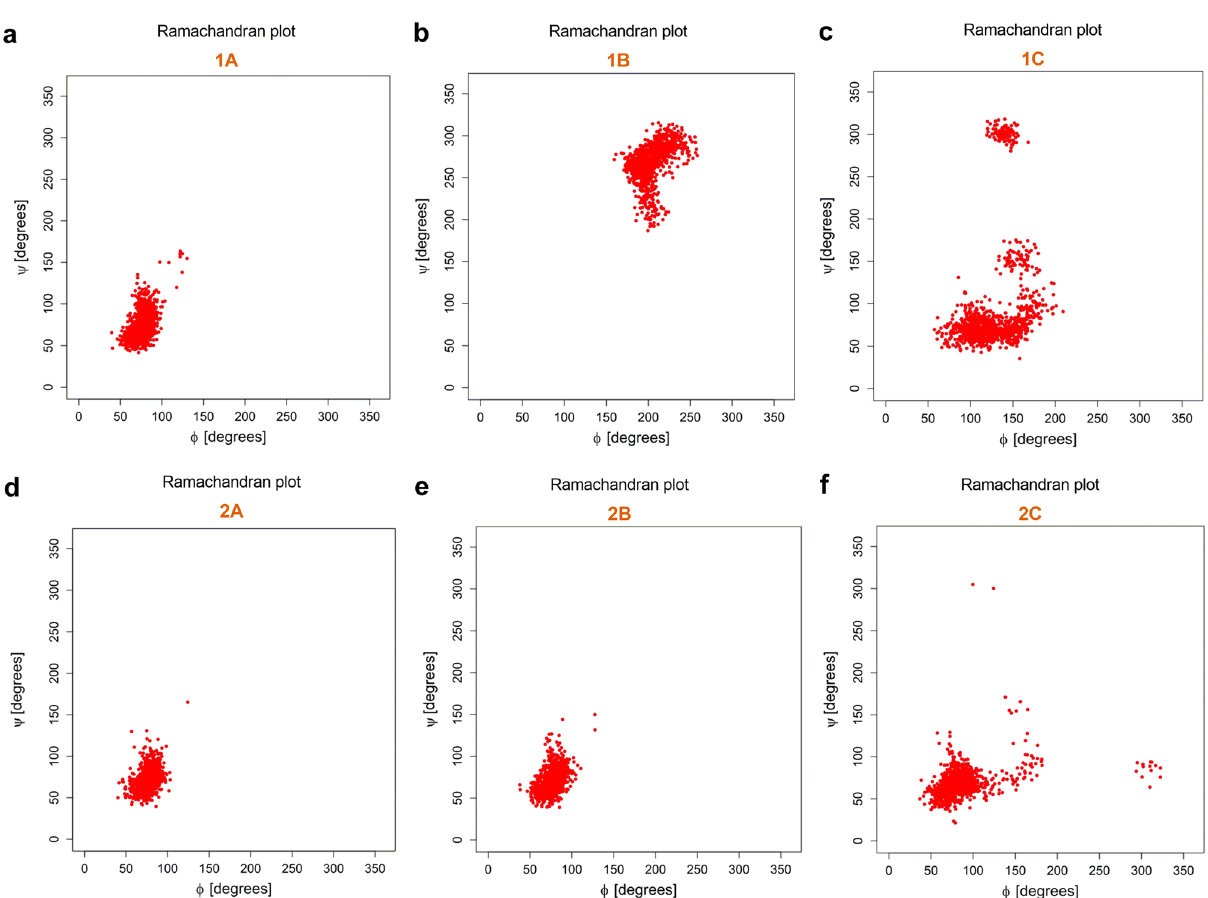
Figure 11. Ramachandran plots of 1A , 1B , 1C , 2A , 2B and